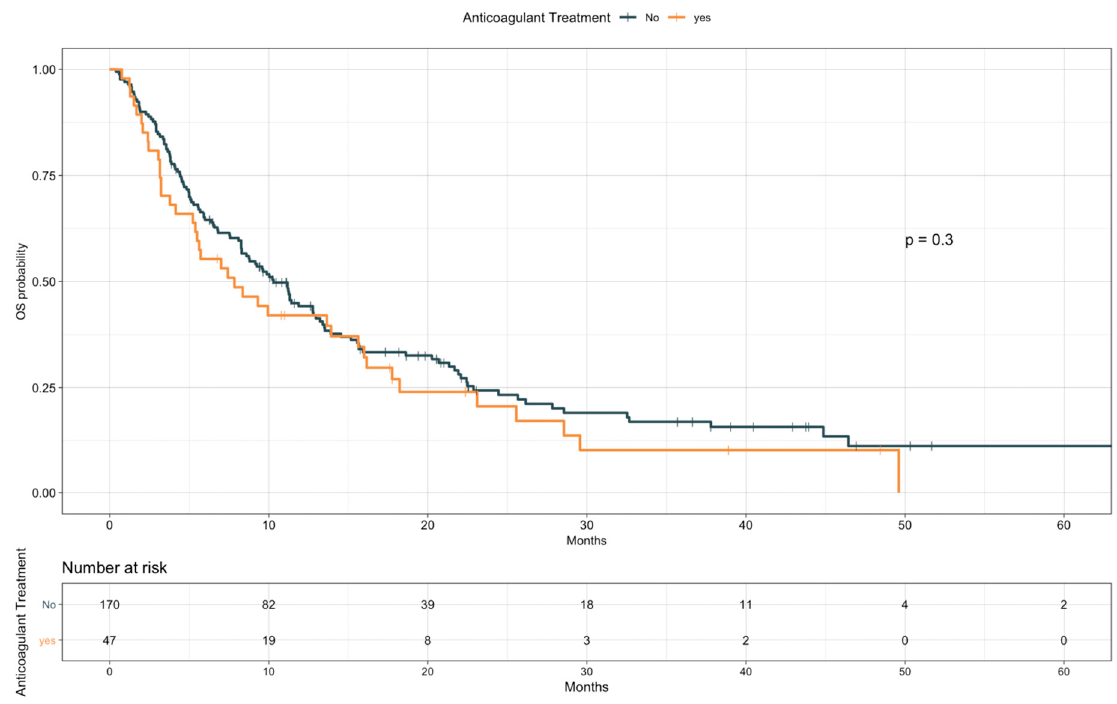
Figure 2. Overall survival according to anticoagulant treatment. Cancers 2020 , 12